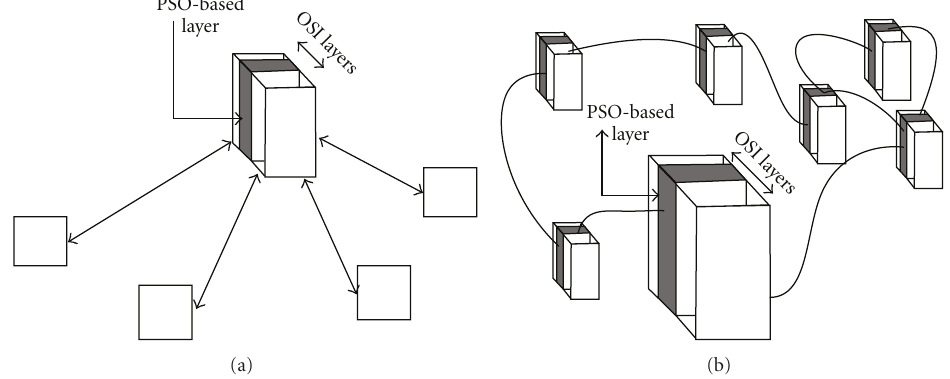
Figure 1: (a) Network model for centralized PSO in a single node. (b) Network model for distributed PSO in an ad hoc network using di ff erent nodes in the